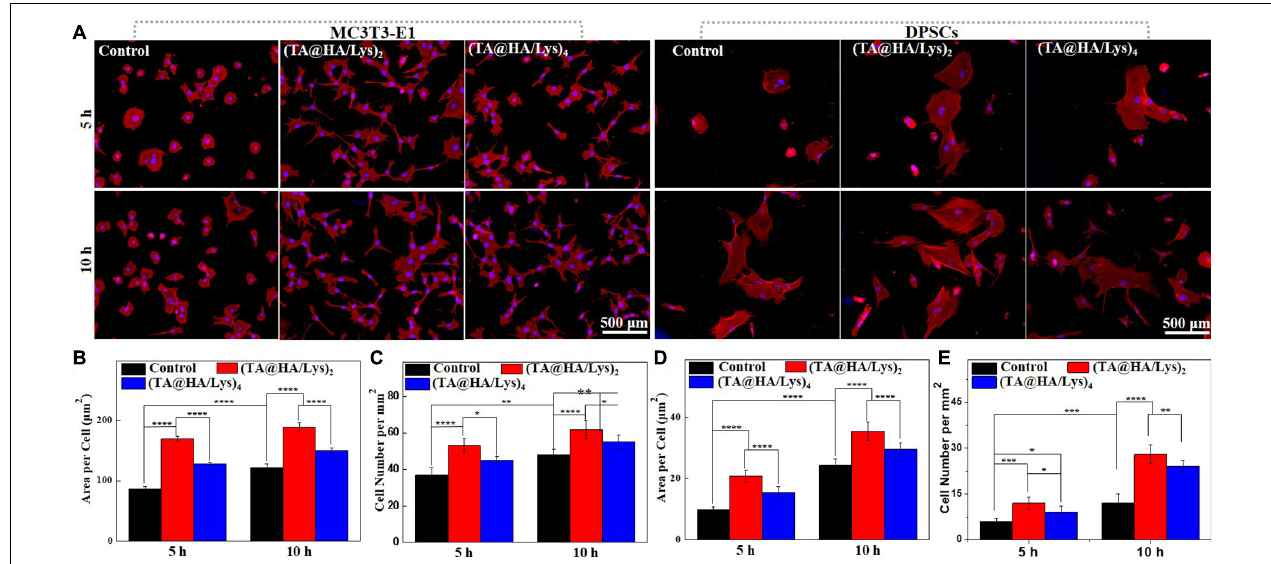
FIGURE 5 | (A) Morphologies of MC3T3-E1 cells and DPSCs cultured on glass coverslips as control (left row), (TA@HA/Lys) 2 (middle row), and (TA@HA/Lys) 4 (right row) substrates for 5 and 10 h. (B) Statistical cell area per cell and (C) cell number per mm 2 of MC3T3-E1 cells. (D) Statistical cell area per cell and (E) cell number per mm 2 of DPSCs. All images were using the same scale bar. * p < 0.05, ** p < 0.01, *** p < 0.001, **** p <